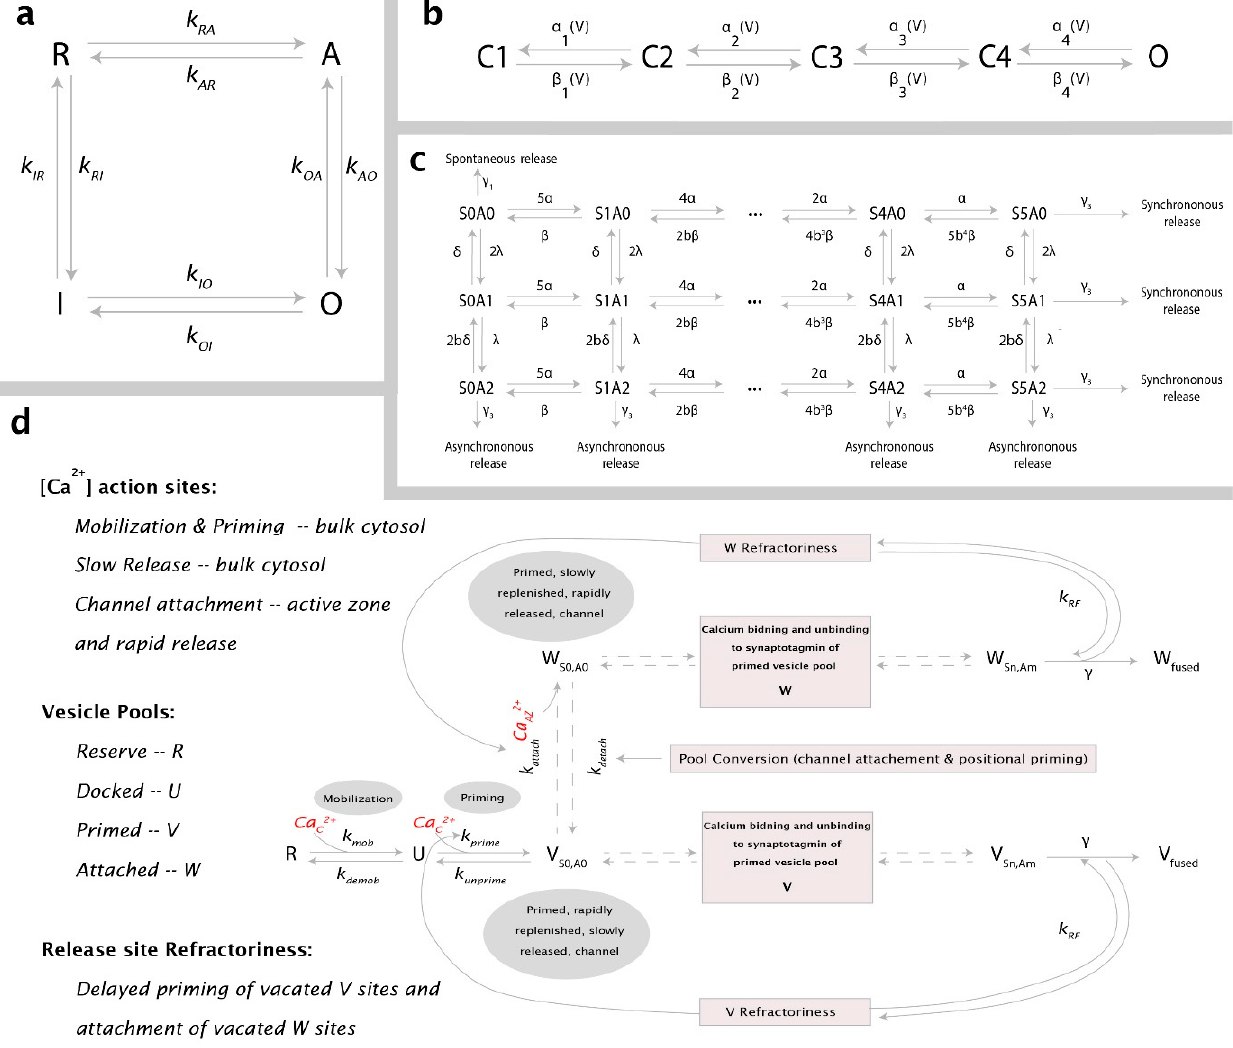
Figure 2. Kinetic schemes used in the model: ( a ) Gating kinetics of IP 3 R. Four − state model representing the possible states along with corresponding transition rates; ( b ) Model for VGCC gating with four closed states (C1–C4) and one open Ca 2+ conducting state (O); ( c ) Scheme for Ca 2+ binding to synaptotagmin with dual Ca 2+ sensors for fast synchronous (S with five Ca 2+ -binding sites), slow asynchronous (A with two Ca 2+ − binding sites), and spontaneous exocytosis; ( d ) Adapted with permission from Ref. [68]. 2009, Elsevier Inc. The overall release scheme, which includes vesicle mobilization from a reserve pool (R) to docked, unprimed pool (U), molecular priming to vesicles unattached to a Ca 2+ channel (V), and conversion to vesicles coupled to a VGCC cluster (W). Both vesicle pools are released through the dual sensor release model. Channel − attached vesicles are strongly dependent on [ Ca 2 + ], whereas [ Ca 2 + ] governs the release of detached vesicles. Reaction rates along with respective references are listed in Tables 6, 8, and 9.